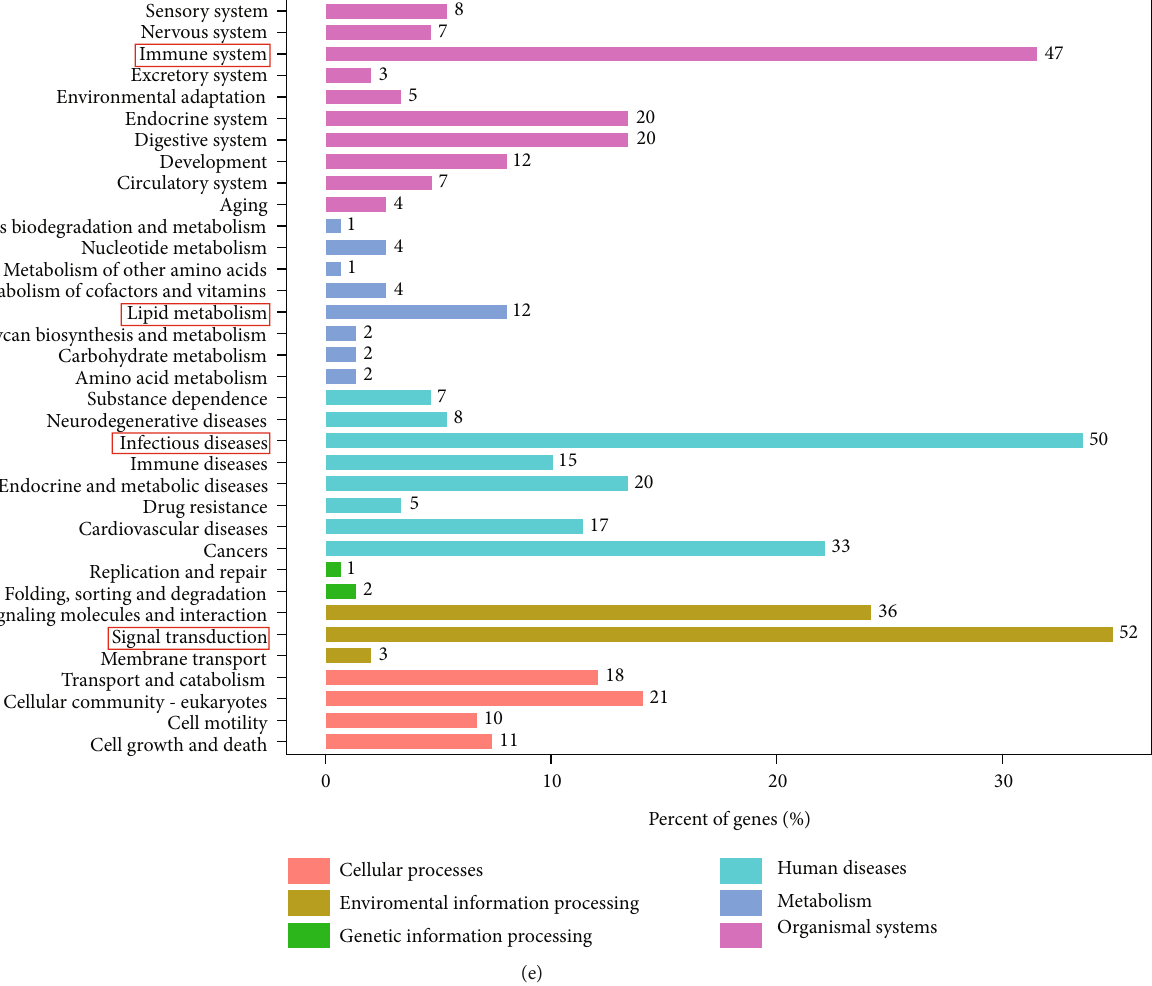
Figure 6: Pro fi ling of di ff erentially expressed genes of skeletal muscle after stroke and exercise protocols. (a) Heat map of di ff erentially expressed genes in each group associated with GO biological process categorization about “ atrophy of muscle, ” “ skeletal muscle fi ber type, ” and “ fatty acid oxidation. ” (b) Venn graph illustrates common and unique di ff erentially expressed genes between di ff erent comparison groups. (c) Heat map of di ff erentially expressed genes between MCAO and sham groups (dependent group t -test p < 0 : 05 and folddifference ≥ 1 : 5 ). Red indicates relatively high expression of protein-coding genes, and blue indicates relatively low expression of protein-coding genes. (d) Volcano map of di ff erentially expressed genes between MCAO and sham groups. Gray represents the genes with insigni fi cant di ff erence. Red and green represent the genes with signi fi cant di ff erence. (e) KEGG pathway analysis of di ff erentially expressed genes, including cellular processes, environmental information processing, genetic information processing, human diseases, and metabolism organismal systems. Abbreviation: GO: Gene Ontology; KEGG: Kyoto Encyclopedia of Genes and